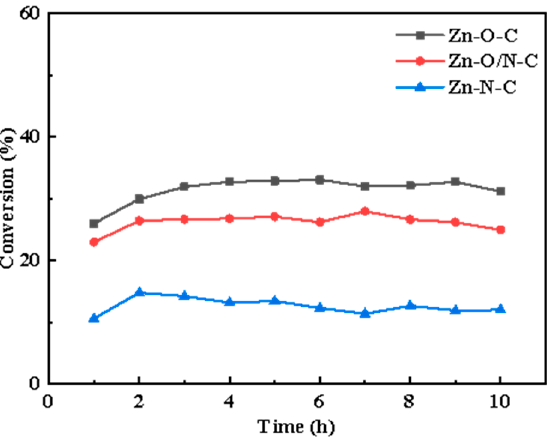
Figure 1. The conversion rate curves of Zn-O-C, Zn-O/N-C, and Zn-N-C catalysts over time, respectively.